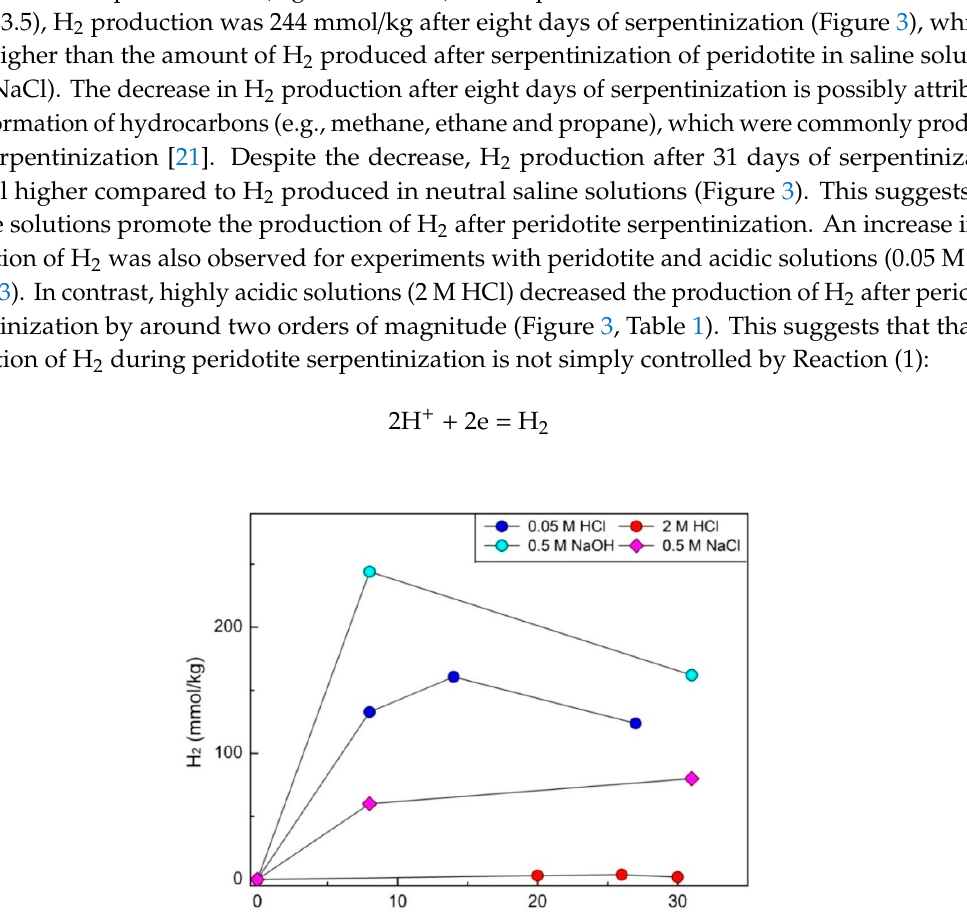
Figure 3. The production of H 2 (mmol/kg) after serpentinization of peridotite as a function of time (days).